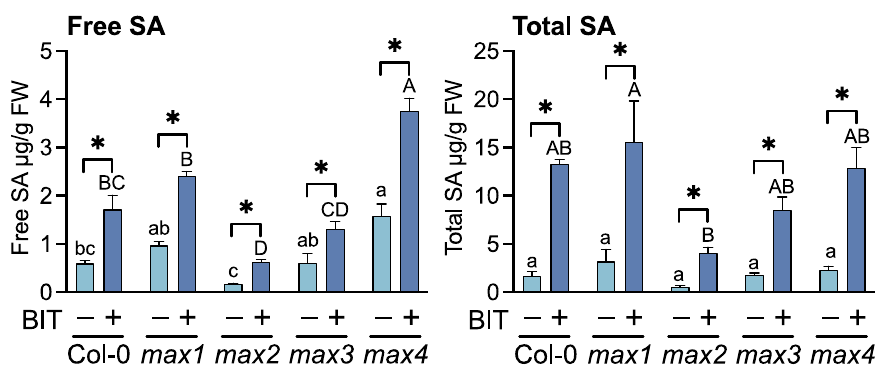
Figure 3. Accumulation of free and total SA in BIT-treated plants. Plants were treated with water (control) (–) or 1 mM BIT (+). Leaves were harvested 3 d after treatment, and free and total SA (free SA + SA glucoside) levels were quantified using high-performance liquid chromatography. Significant differences between control and BIT-treated plants are indicated by * (unpaired t -test, p < 0.05). Different letters indicate significant differences between accessions of the same treatment (Tukey’s multiple comparison test, p <